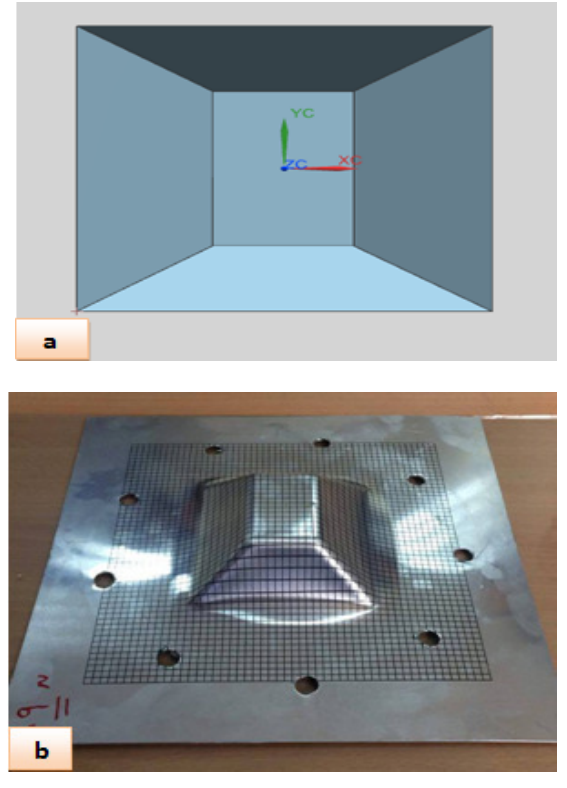
Fig. 10. Product geometry, a) top view, b) formed shape .